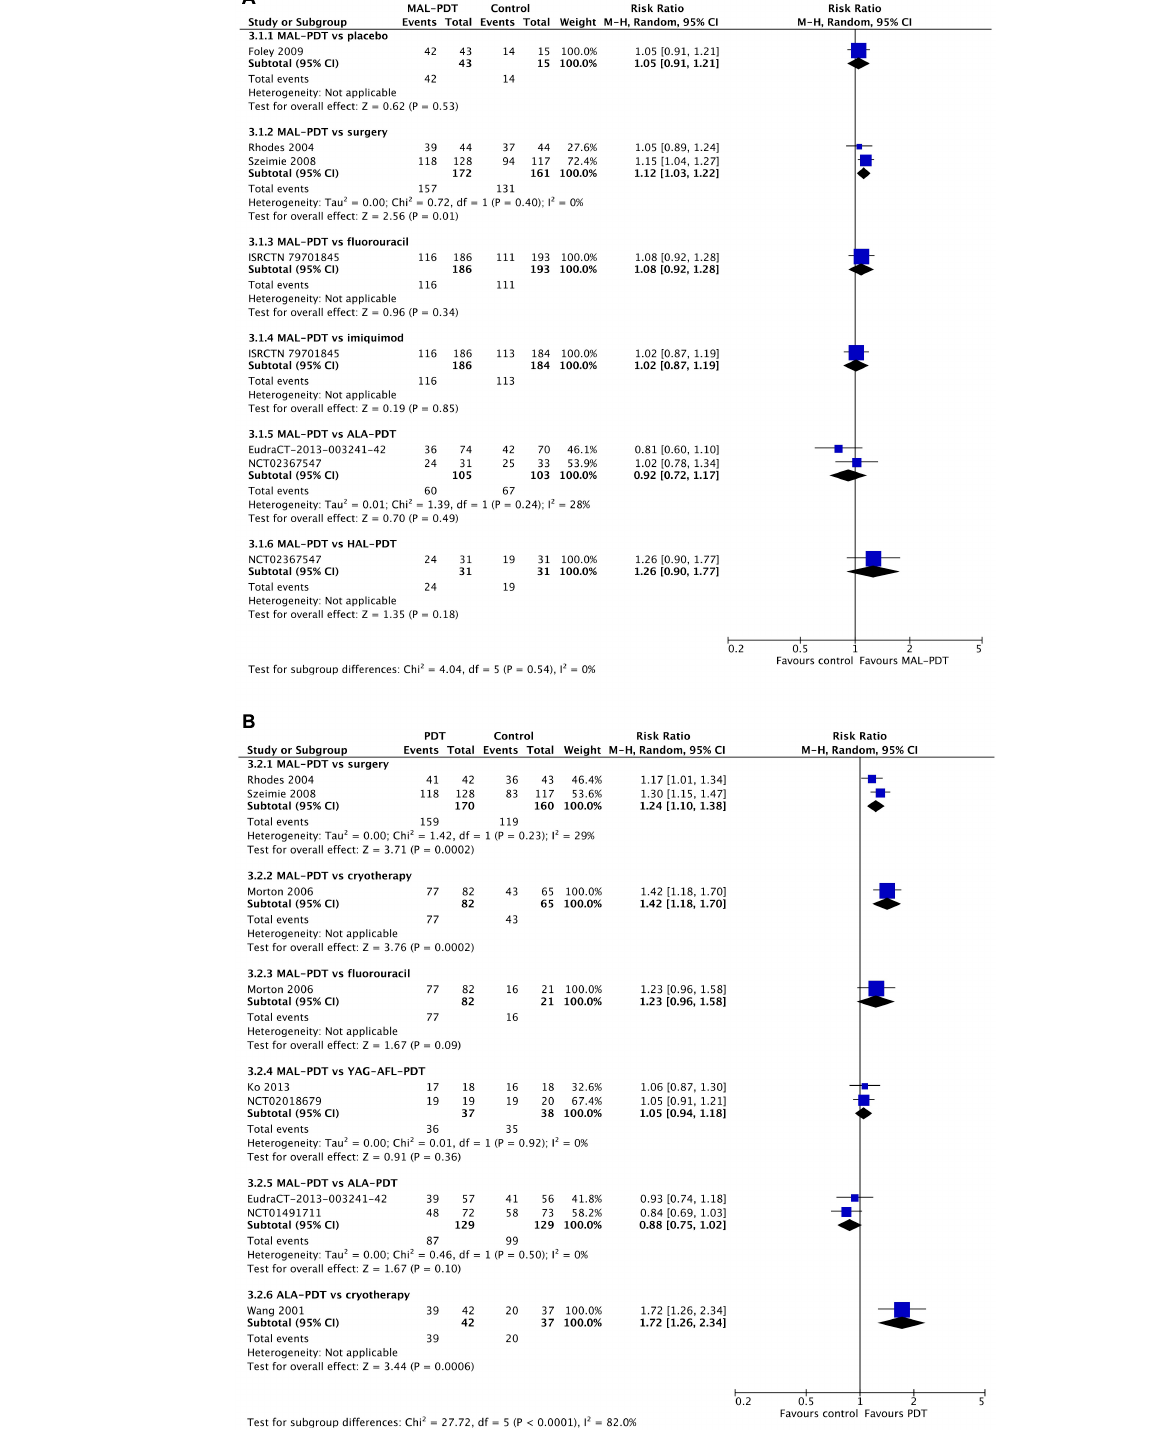
FIGURE6 Meta-analysis of the risk of a cosmetic rating of “good” or “excellent” at 3 months (A) or 12 months (B) post-intervention by comparator. Data are risk ratios with 95% confidence intervals.